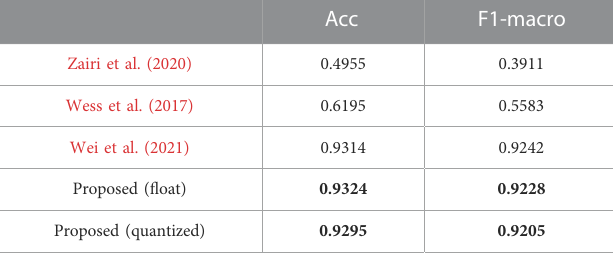
TABLE 1 Classi fi cation performance